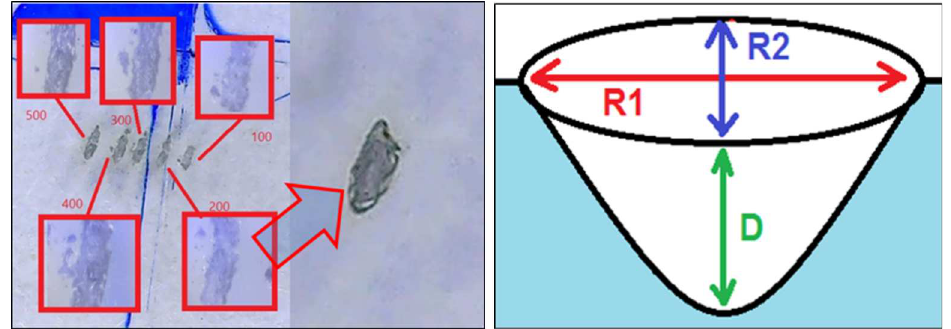
Fig 3. Resultant ablation on PMMA. (a) at different number of pulses, and (b) illustration of the cone-like shape in the depth direction.